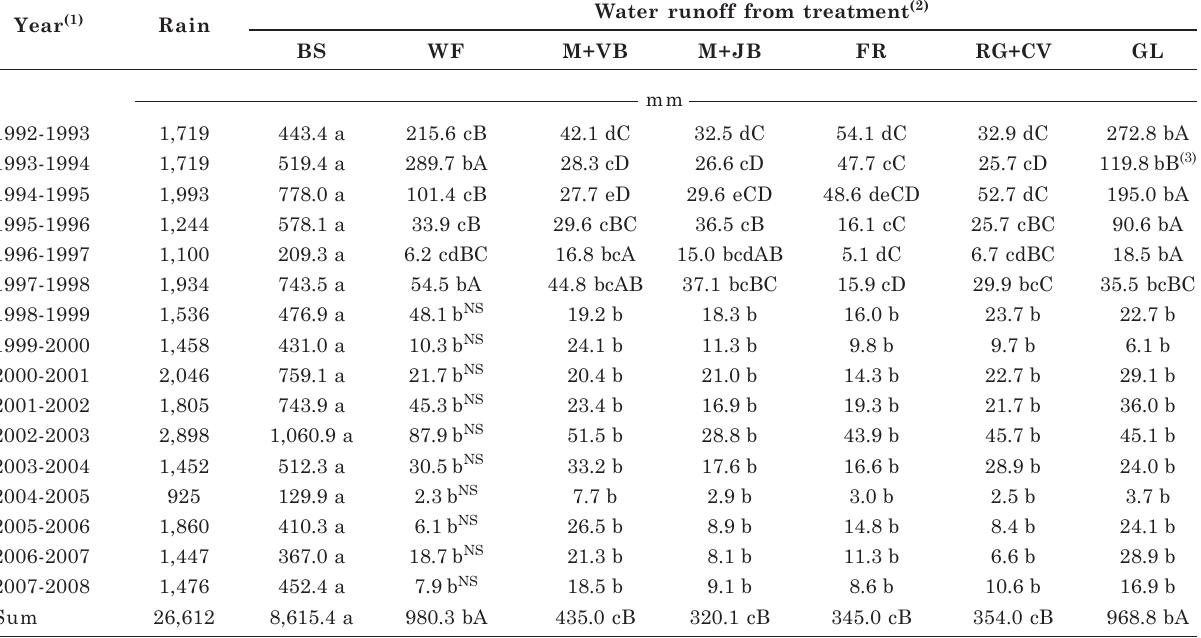
(1) Corresponding to the period between April of the first year and March of the following year. (2) BS: bare soil; WF: winter fallow; M+VB: intercrop maize - velvet bean; M+JB: summer consortium maize - jack bean; FR: forage radish; RG+CV: winter consortium ryegrass - common vetch; GL: grassland. (3) The periods of the treatments BS and GL were not compared since the regression analysis (Figure 1) detected no significant changes of soil loss rate over the years. (4) The periods in treatments BS and M+VB were not compared since no significant changes in water runoff rate over years were detected by regression analysis (Figure 2). Means followed by the same lowercase letter for the same period in the comparison among all treatments (a,b) or for the same treatment in the comparison of different periods (x,y) were not different by the LS means test (p<0.05). Means followed by the same uppercase letter for the same period are not different by the LS means test (p<0.05) in the comparison of treatments WF, M+VB, M+JB, FR, RG+CV, and GL. ns Not significant by the F test (p>0.05) in the comparison among periods at the same treatment; NS not significant by the F test (p>0.05) in the comparison of the treatments WF, M+VB, M+JB, FR, RG+CV, and GL for the same period. Table 4. Water runoff in a long-term experiment, comparing bare soil, grassland and cropping